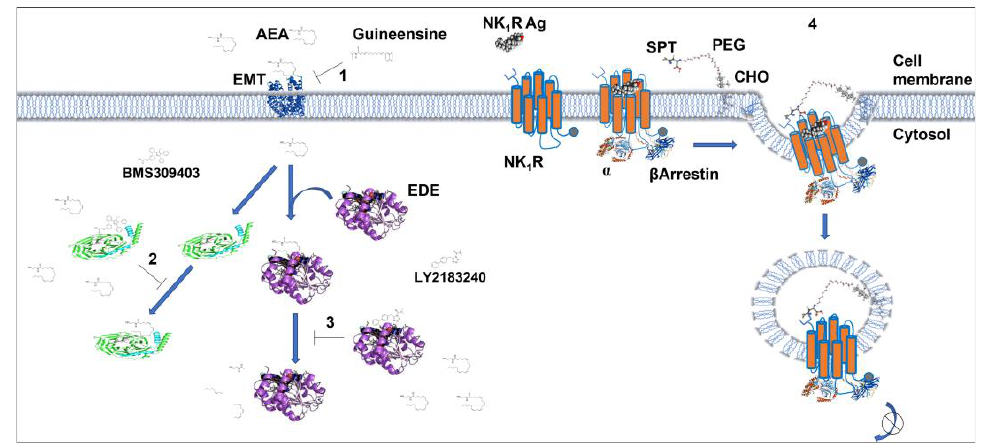
Figure 4. Compartmentalized GPCRs as novel pharmacological targets. The endogenous ligand anandamide (AEA) after uptake by the endocannabinoid membrane transporter (EMT) interacts with cytosolic proteins such as albumin, HSP70, FABP5 and is degraded by fatty acid amide hydrolase and monoacylglycerol lipase enzymes (EDE). These steps can be pharmacologically targeted to decrease (guineensine, “1”; BMS309403, “2”) or increase (LY2183240, “3”) the intracellular levels of AEA, modulating its compartmentalized intracellular signaling effects. Intracellular GPCR signaling is also blocked by conjugation of receptor-specific antagonists. NK1R is depicted as a seven-transmembrane orange protein, whose gray dots represent carboxyl groups, and the N-terminal group is a blue symbol. Antagonists of neurokinin type 1 (NK1) and spantide (SPT), when conjugated with polyethylene glycol (PEG) and cholestanol (CHO), inhibit signals that originate from endosomal NK1 receptors emphasizing the physiological importance of GPCR signaling from endosomes